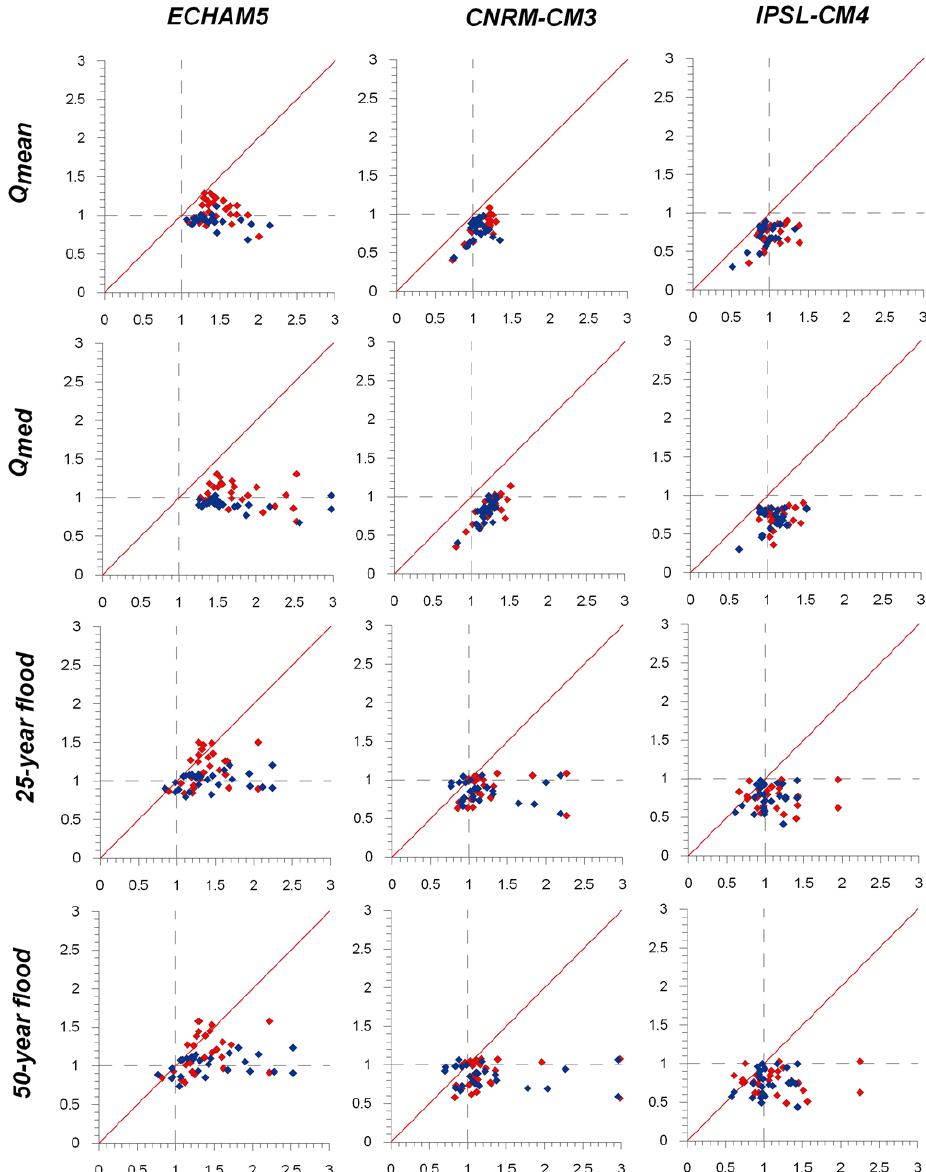
Fig. 3. Scatter plots between the CFs derived from the statistical bias corrected time series (x-axis) and the CFs resulting from the delta change time series (y-axis), separately for all indices and GCMs. In each plot, the data points of the A2 emission scenario are depicted in red and the data points of the B1 emission scenario are depicted in blue. The solid red line represents the 1:1